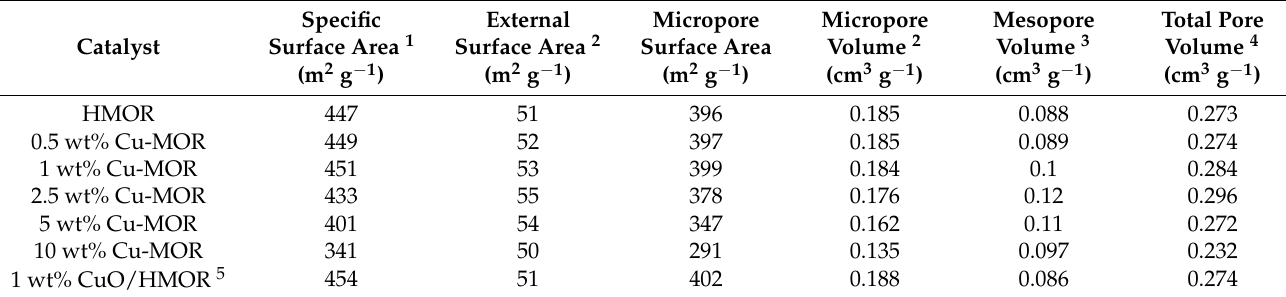
Table 1. Textural properties of HMOR and Cu-MOR